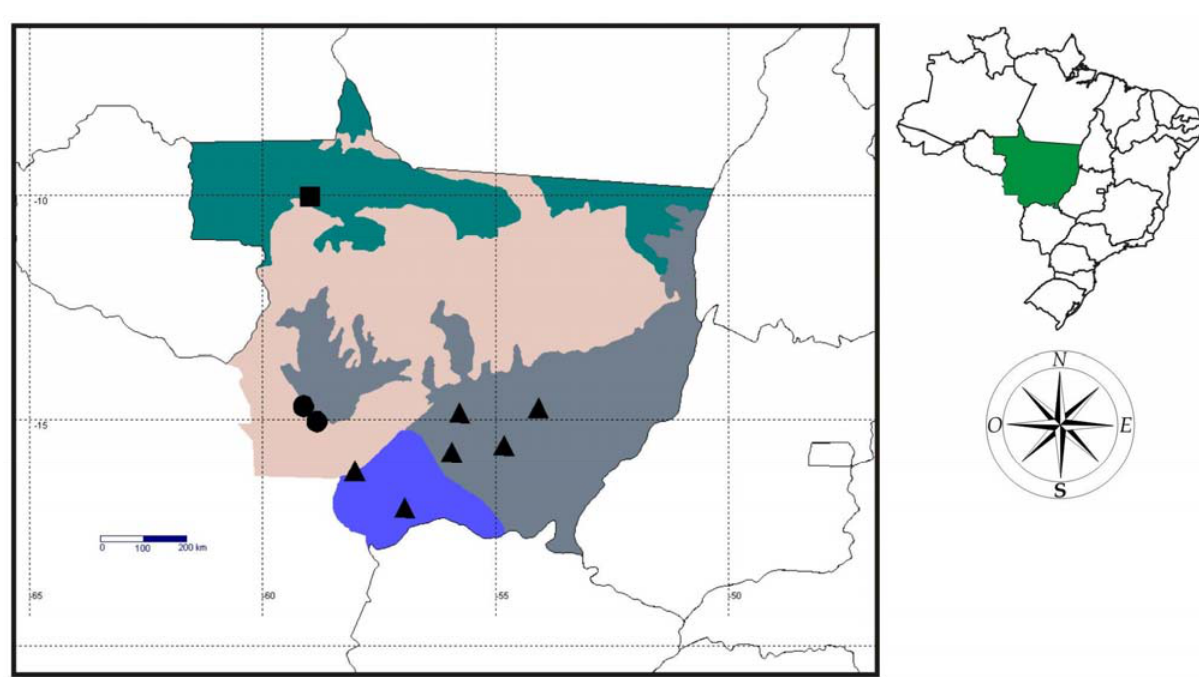
Figure 1 . Known g eographic distribution of Polychrus spp. in the state of Mato Grosso, Brazil; triangles, P. acutirostris ; square, P. marmoratus ; circles, P. liogaster . Colors represent biomes: green, Amazon; gray, Cerrado; rose, transition zones; blue, Pantanal.